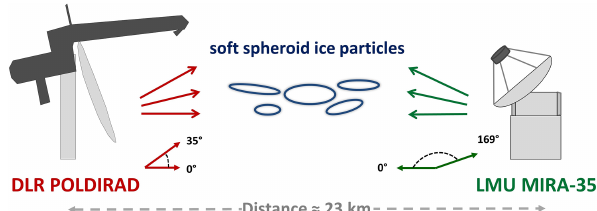
Figure 2. Geometry of the radar setup. The range of elevation an- gles is 0–35 and 0–169 ◦ for POLDIRAD and MIRA-35, respec-